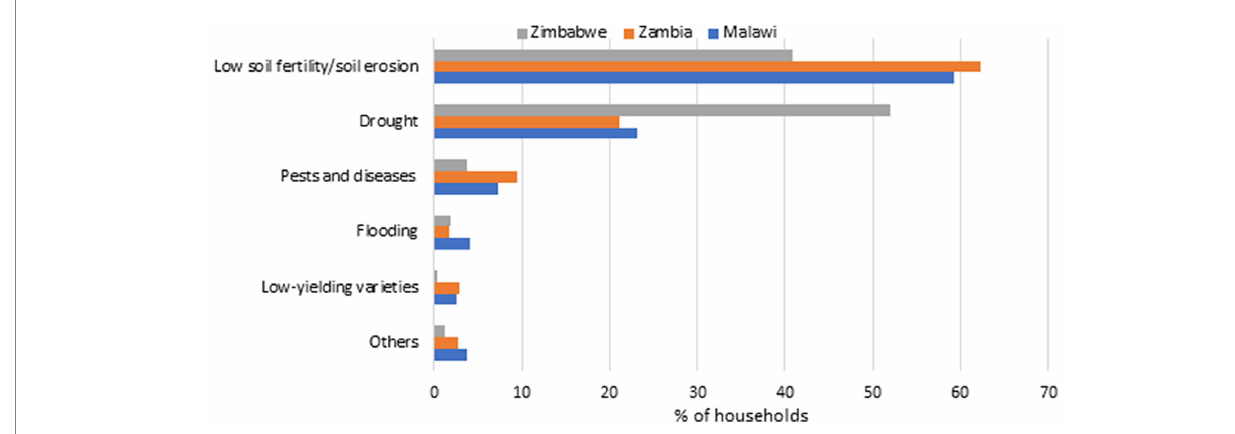
FIGURE 3 Major constraints to maize production disaggregated by country (% households).